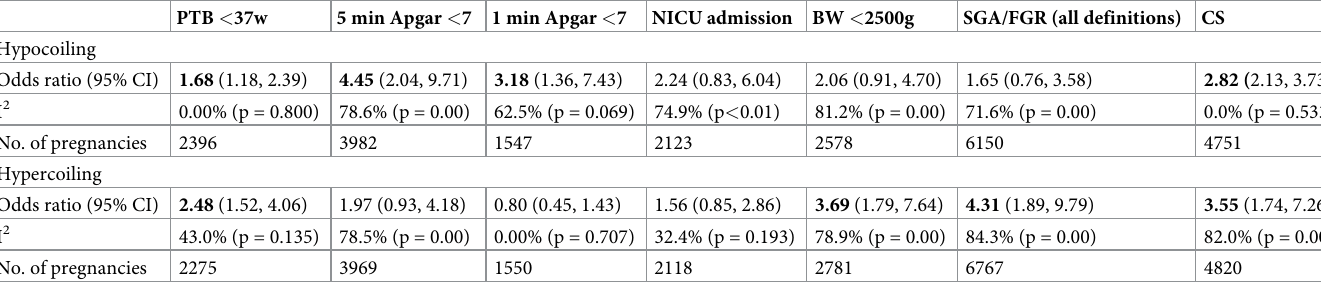
Table 4. Analyses of the relationship between abnormal coiling and adverse outcomes.